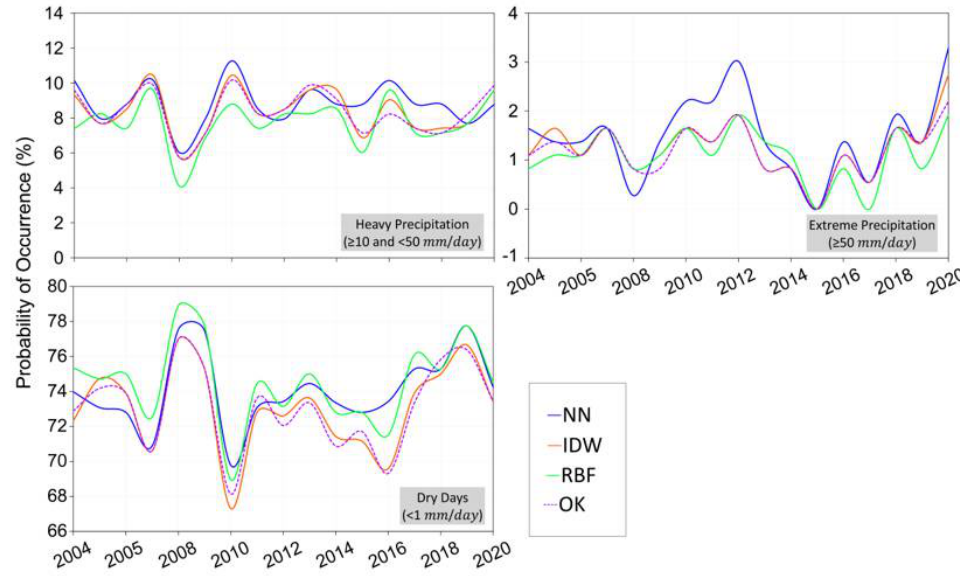
Figure 7. Probability of occurrence of dry days, days with heavy precipitation, and days with extreme precipitations based on the default NN-, IDW-, RBF-, and OK-based areal precipitations.